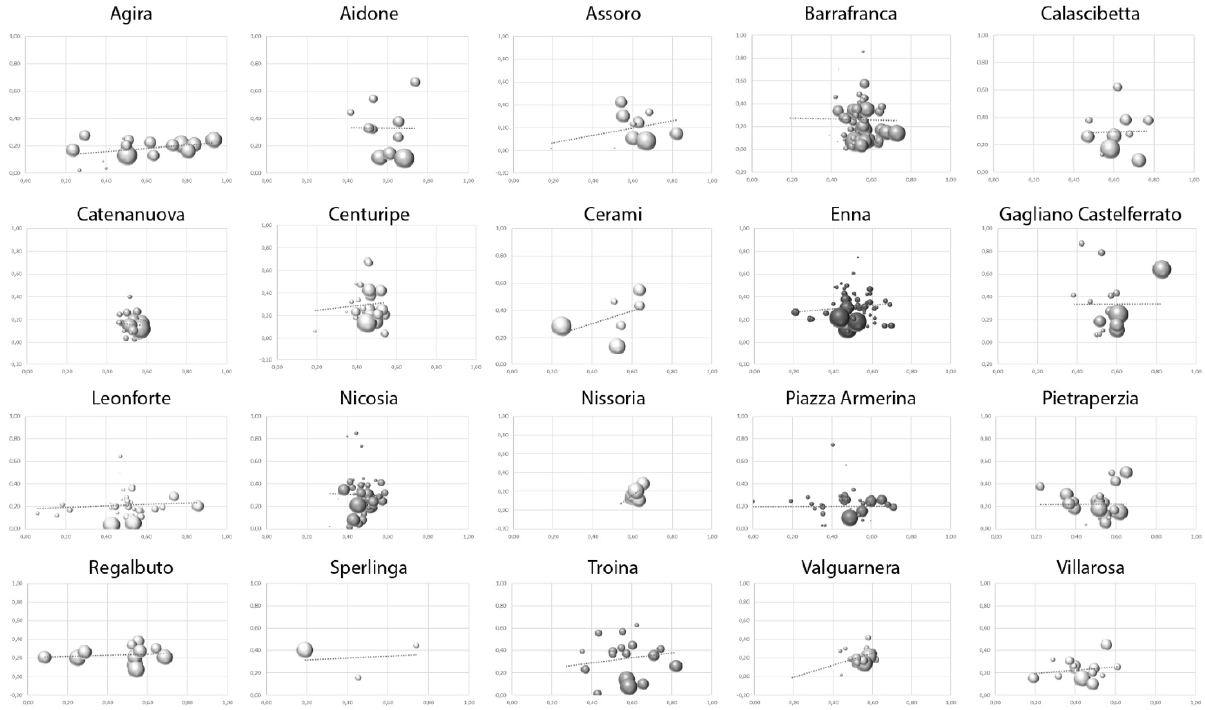
Figure 10. Relation between urban-landscape value (abscissa) and old-age index (ordinate) over the 20 municipalities; the bubble size measures the surface area of the Census Section.